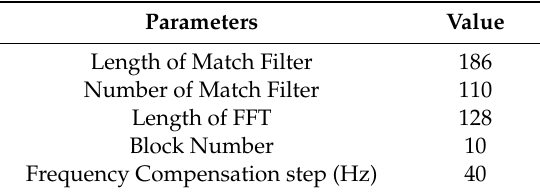
Table 1. PMF-FC-BA-FFT acquisition parameters.